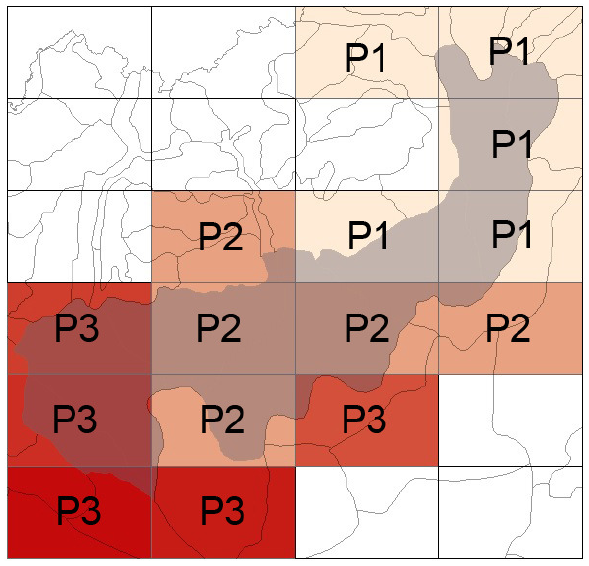
Figure 5: Distribution of the sub raster blocks to a region based processing